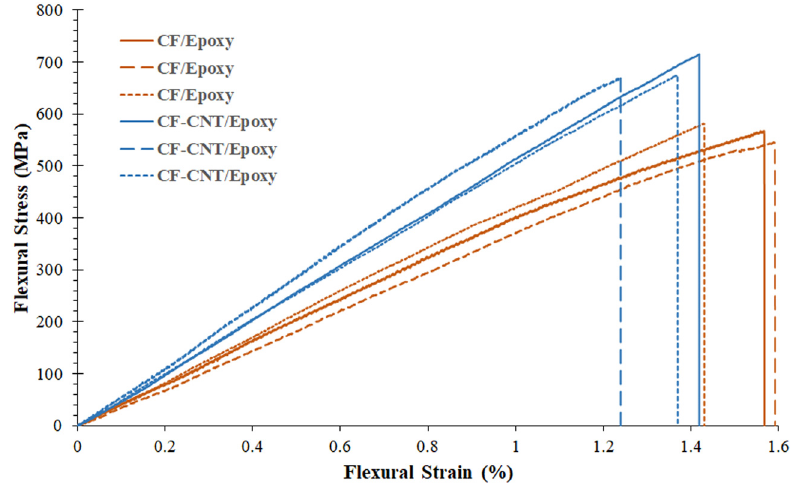
Figure 7: Flexural stress – strain curves of CF/epoxy and CF – CNT/epoxy.